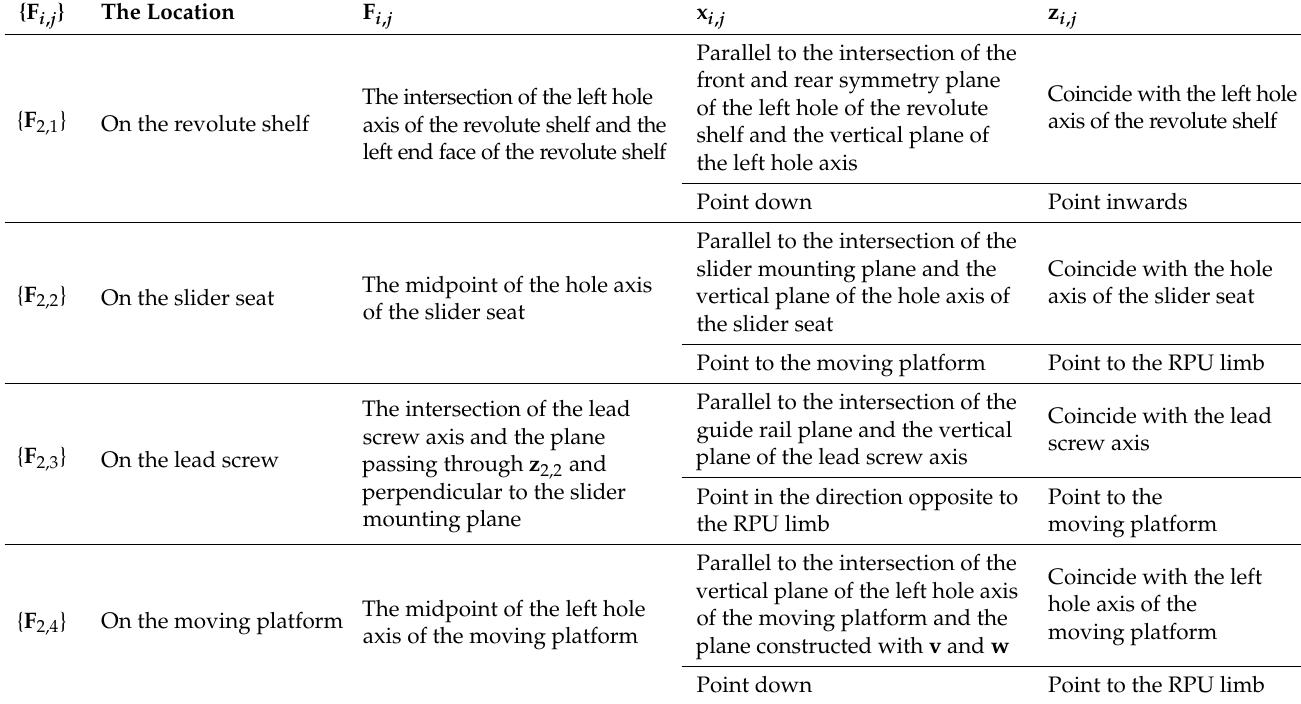
Table 2. Definitions of local coordinate systems for the second UPR